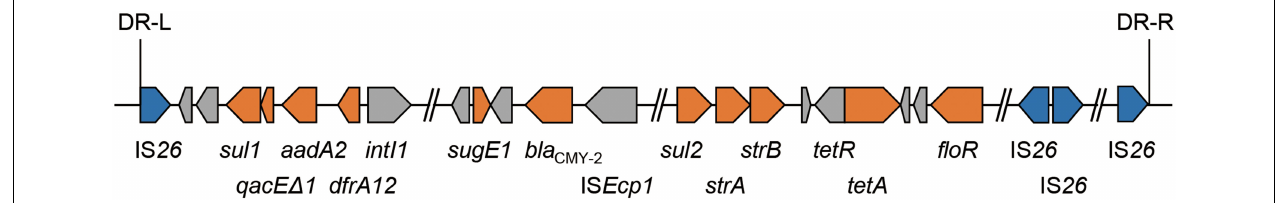
FIGURE 1 | Schematic view of antimicrobial resistance regions located in GI-VII-6. Each arrow indicates gene according to the following scheme: blue, genes for IS 26 transposase; orange, resistance genes; gray, other genes. GI-VII-6 were flanked by an 8-bp direct repeat.